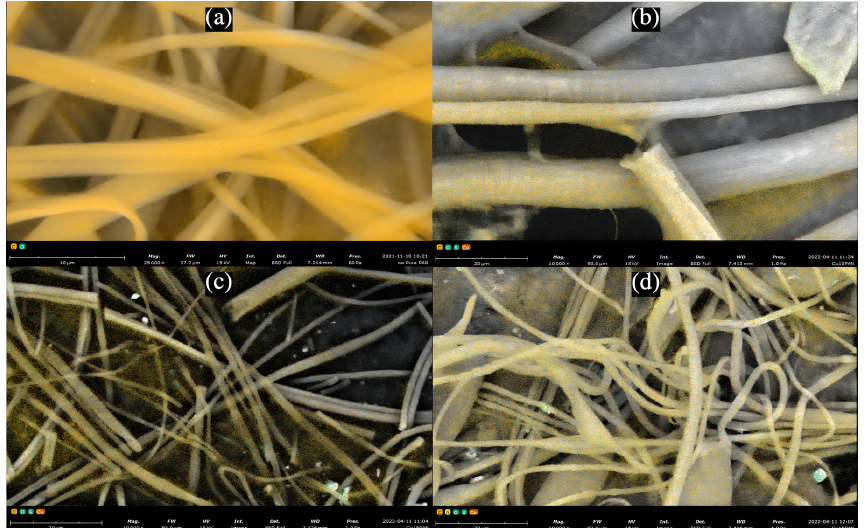
Figure 4. ( a ) SEM Elemental Distribution of Pure PAN Nanofibers ( b ) SEM Elemental Distribution of 5% PAN-CuNP Nanofibers ( c ) SEM Elemental Distribution of 10% PAN-CuNP Nanofibers ( d ) SEM Elemental Distribution of 15% PAN-CuNP Nanofibers.